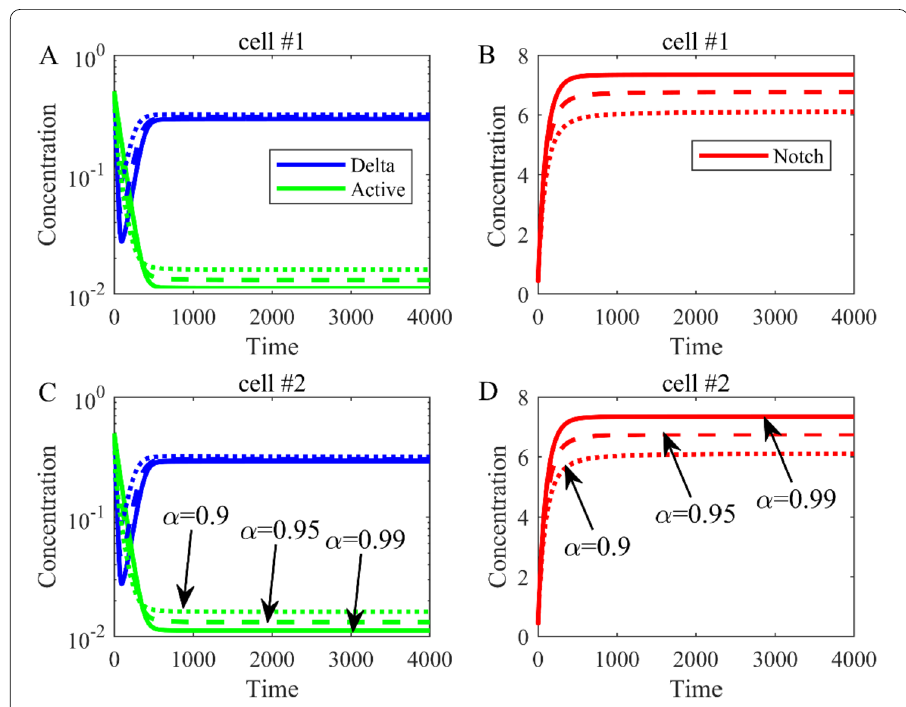
Figure 4 The dynamical trend of Delta, Notch, and active Notch when λ (cid:8) = 0. ( A ) The dynamical trend of Delta and active Notch in cell 1. ( B ) The dynamical trend of Notch in cell 1. ( C ) The dynamical trend of Delta and active Notch in cell 2. ( D ) The dynamical trend of Notch in cell 2